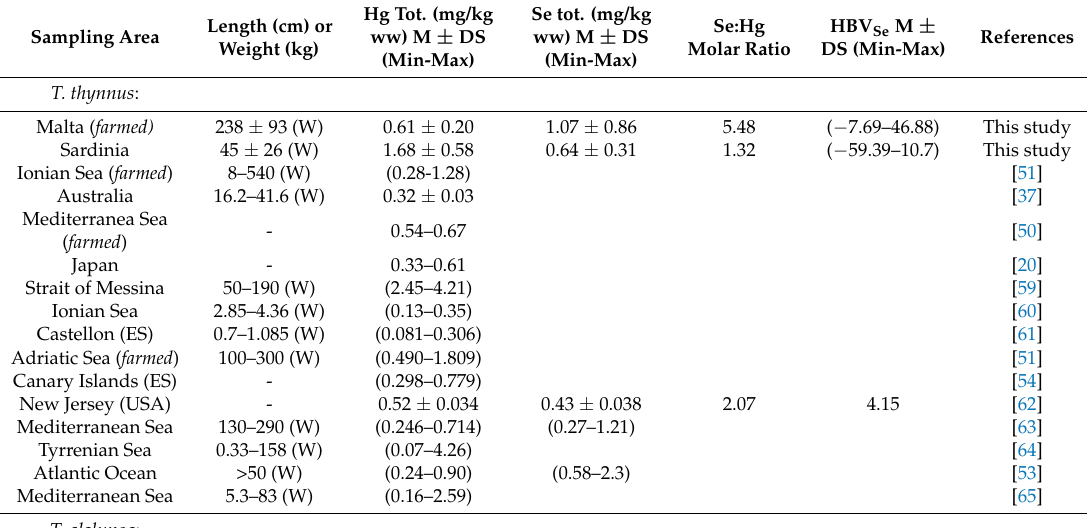
Table 3. Comparison with literature